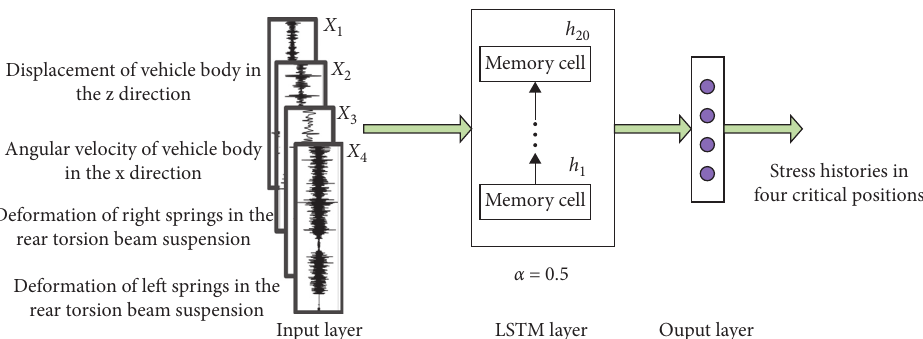
Figure 7: Final architecture of the LSTM used for stress histories